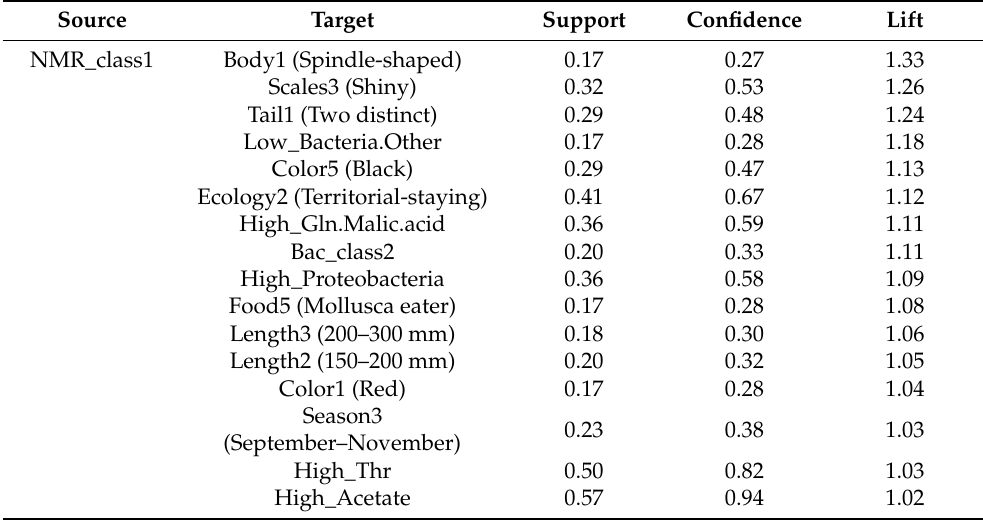
Table 4. Extracted association-rule-correlated NMR class information from i-means result to other